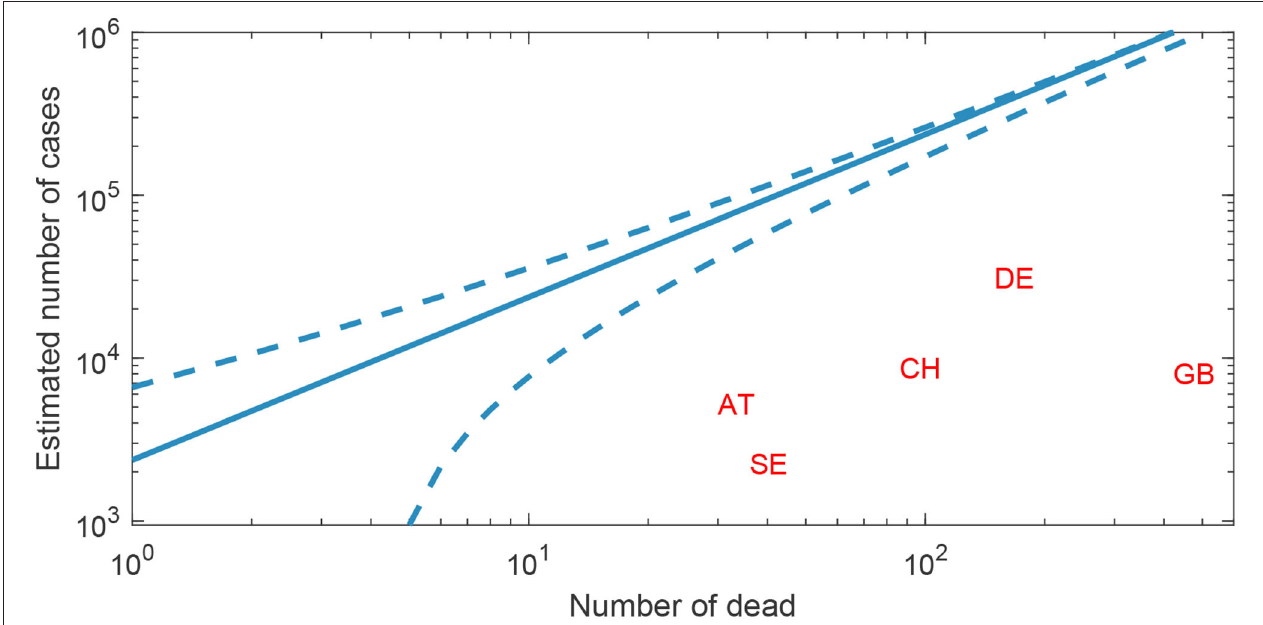
FIGURE 3 | Predicted number of COVID-19 cases based on the reported number of deaths. The predicted cumulative number of COVID-19 cases (solid line) depending on the number of reported deaths, with 95% indicative confidence intervals (dashed line), here based on a doubling time of 4 days and an infectious fatality ratio of 0.8%. Two letter country codes indicate the country’s reported deaths and cases based on European Center for Disease Prevention and Control data from March